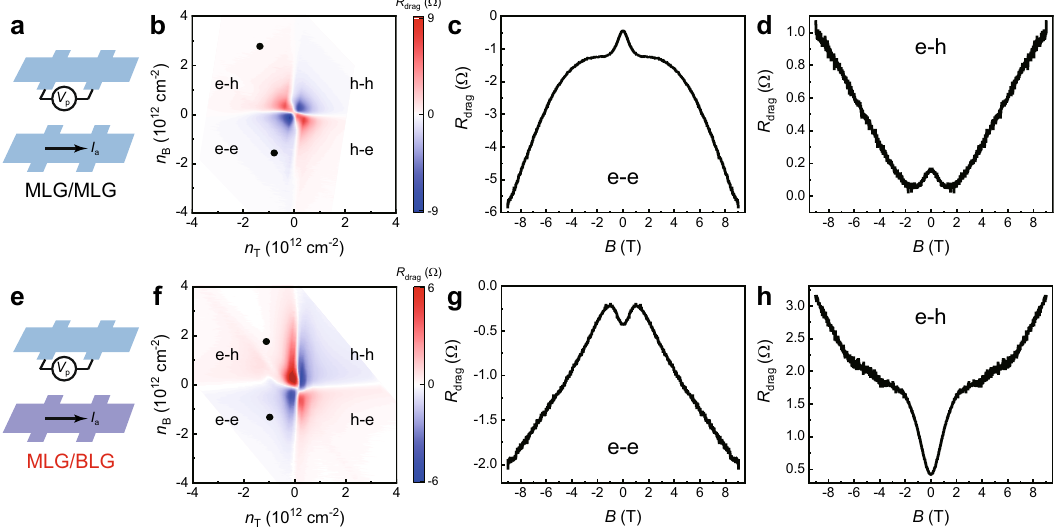
Fig. 4 | Typical magneto-drag data for the monolayer/monolayer graphene (MLG/MLG) and monolayer/bilayer graphene (MLG/BLG) devices. a Schematic of the MLG/MLG device and b the measured R drag vs. ( n T , n B ) mapping. The insu- latingspacingofthisdeviceis~11.7nm. c , d R drag vs. B curvesforpointsindicatedin